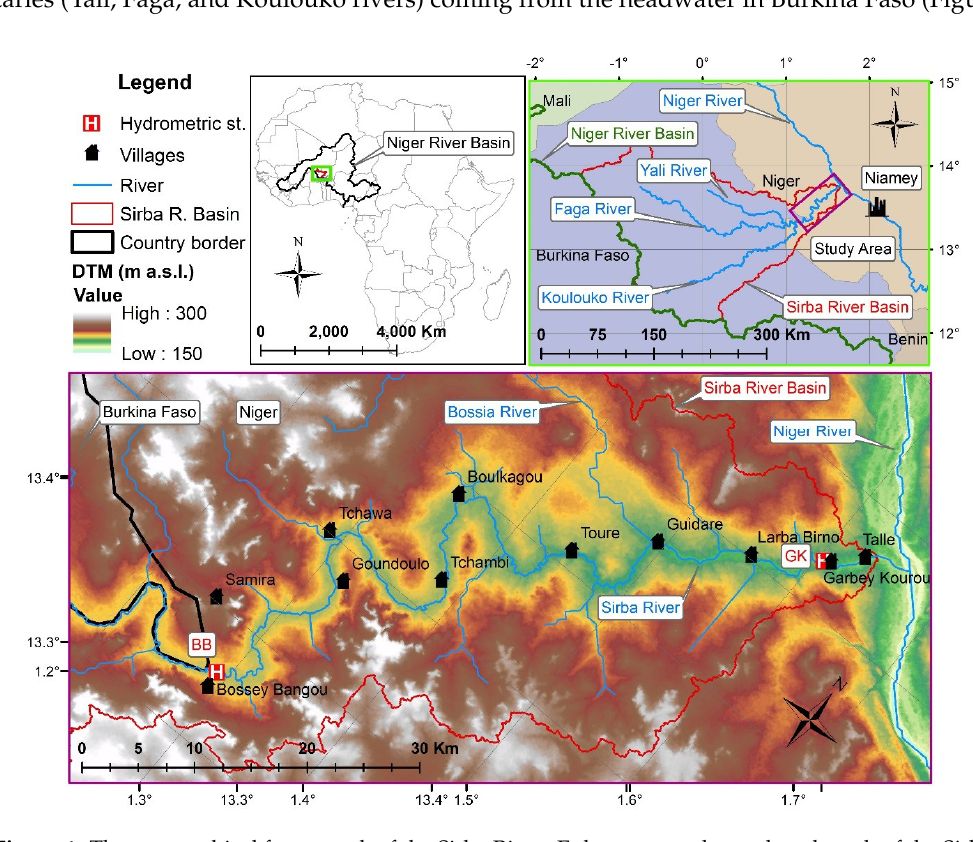
Figure 1. The geographical framework of the Sirba River. Enlargement: the analyzed reach of the Sirba River and main riverine villages. Top left: the continental overview of the Niger River Basin. Top right: the Sirba River basin in the context of the Middle Niger River Basin. Sources of layers: hydrologic